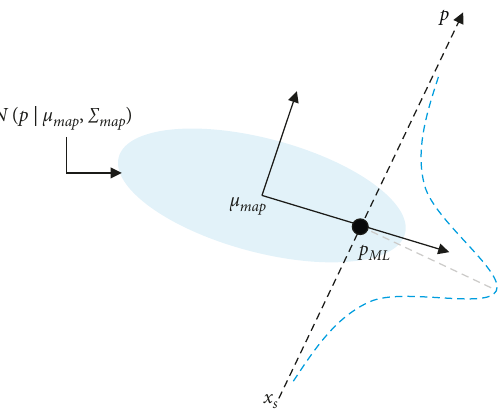
Figure 8: Maximum likelihood point in normal